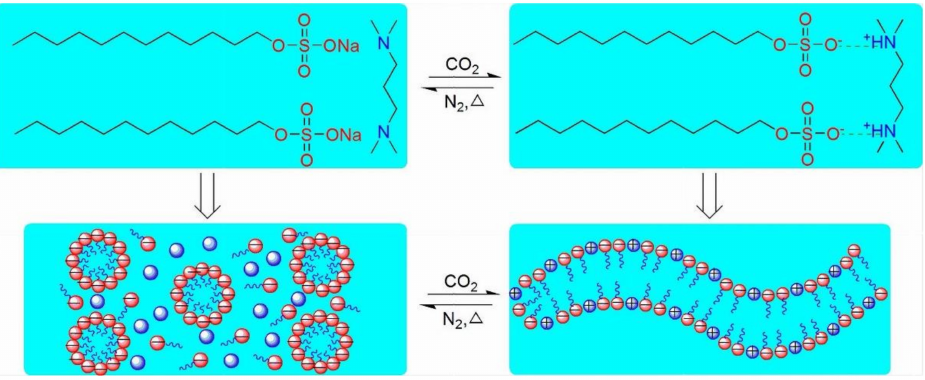
Figure 5. The figure depicts the Pseudogemini Surfactant Micellar System’s Switching Mechanism [88]. In another research by Zhang et al. [104], the viscoelastic wormlike micelles generated by natural sodium erucate (C 22 H 41 NaO 2 ) after bubbling CO 2 were studied. In addition, the rheological behaviors of micellar solutions compared to another carbon dioxide–responsive wormlike micelles were investigated. It becomes turbidity when 100 mM erucic acid aque- ous solution is combined with bubbling carbon dioxide at 60 ◦ C to saturation (pH = 6.63). After bubbling nitrogen at 85 ◦ C to replace carbon dioxide, the pH raised to 9.22 (9.72 at 100 ◦ C), at which point the solution becomes less viscous and turbidity decreases.